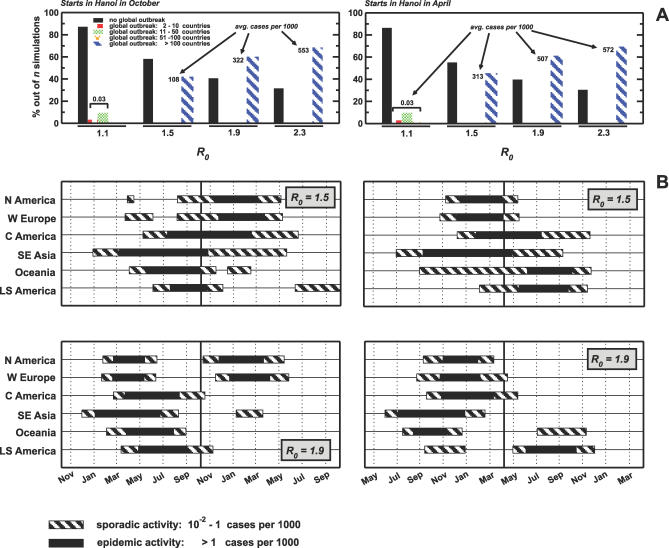
Baseline Scenario: Probability of Global Outbreaks and Expected Evolution for a Pandemic Seeded in Hanoi(A) Probability of observing a global outbreak after one year from the beginning of the epidemic, for the values R0 = 1.1, 1.5, 1.9, and 2.3. A global outbreak occurs when more than one country reports infected cases, while the absence of a global outbreak is given by an epidemic affecting the initially seeded country only. Two different dates for the start of the pandemic are shown: October (left) and April (right). The average attack rates in the case that a global outbreak occurs are also reported, by showing the average number of cases per 1,000 at the end of the first year. Results are obtained from n = 500 different realizations of the noise.(B) Timing of the influenza pandemic in the six regions under study, for R0 = 1.5 and R0 = 1.9, for two different initial dates: October (left column) and April (right column). Sporadic activity occurs when the average prevalence reports (10−2 − 1) cases per 1,000, while epidemic activity is defined by more than one case per 1,000. The average profile is obtained by considering all runs for each region that experienced an outbreak in the region itself during the time window investigated. The thick vertical line corresponds to one year after the start of the pandemic.